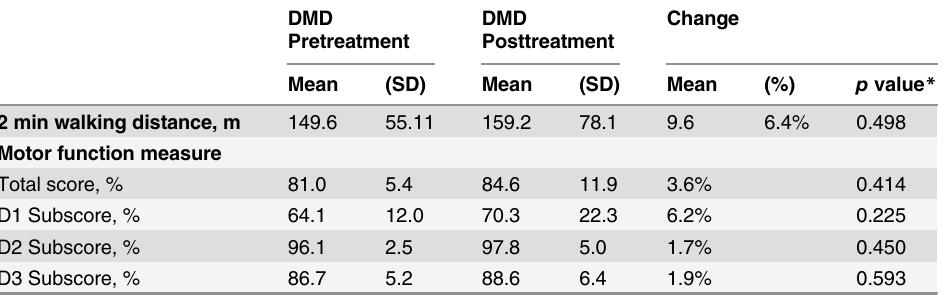
Table 4. Summary of clinical